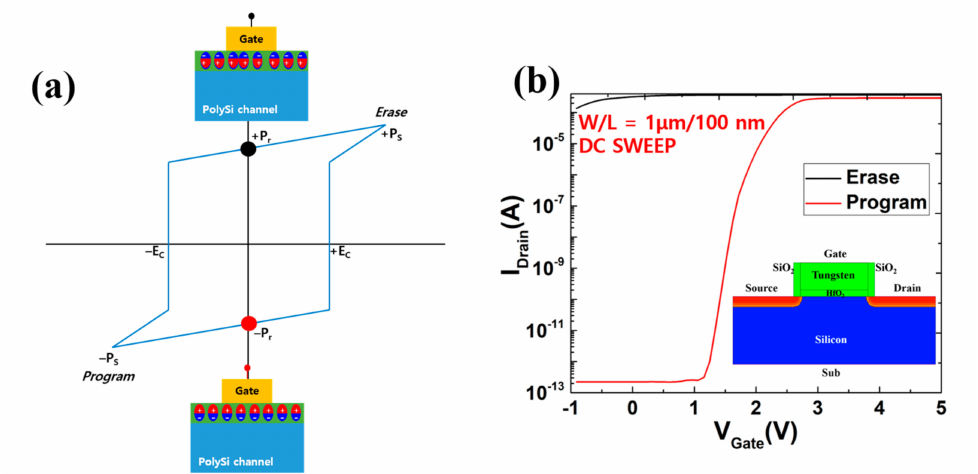
Figure 1. Shows the operating characteristics of ferroelectric memory. ( a ) describes the hysteresis curve of the ferroelectric memory and the corresponding operating characteristics, and ( b ) shows the operating characteristics in the